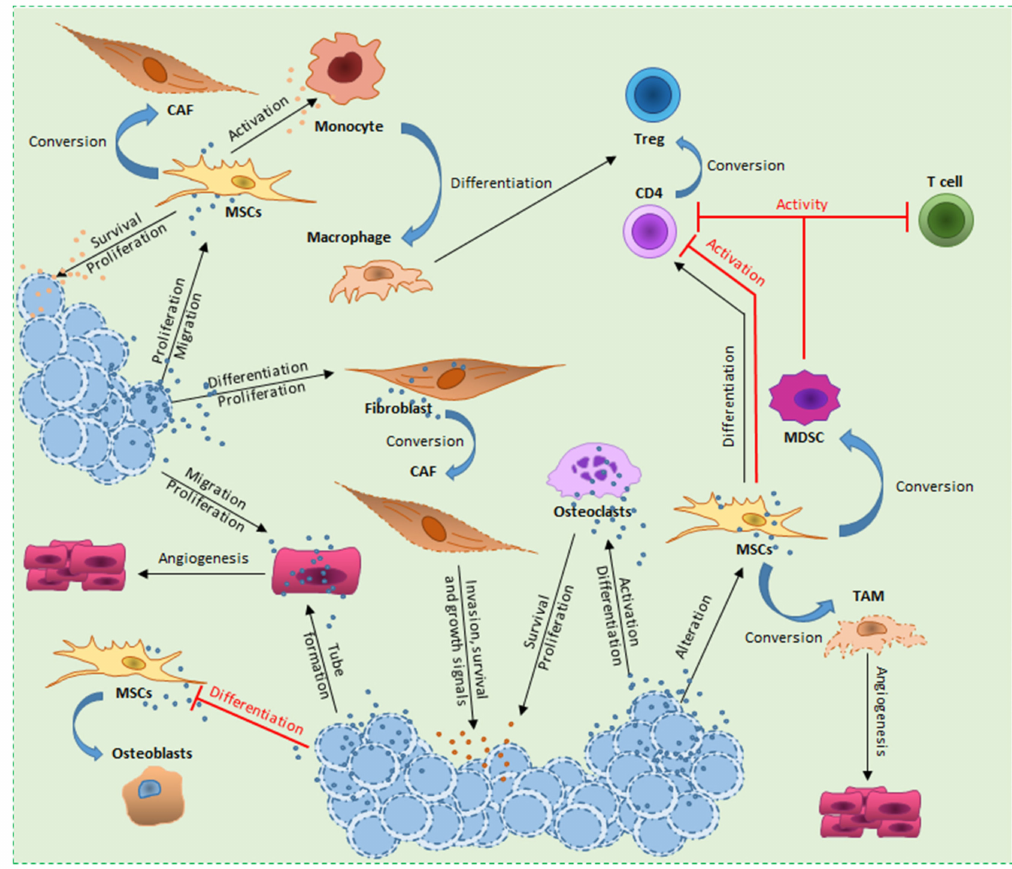
Figure 2. Overview of hematological malignancy-derived small EV effects on stromal cells. In the tumor-stroma communication, TEVs play an essential role in re-shaping the microenvironment. Small EVs coming from di ff erent tumors have been described to induce di ff erentiation and increase proliferation of fibroblasts. Through the transfer of di ff erent molecules, TEVs convert fibroblasts and MSCs into CAFs which in turn boost tumor invasion, survival and growth. TEVs have the ability to block the MSCs physiological di ff erentiation into osteoblasts causing a progressive bone loss. Under the activity of TEVs, MSCs are further altered in proliferation and migration, resulting in the release of MSC-derived small EVs which in turn boost survival and proliferation of the tumor cells. MSC-derived small EVs mediate immunosuppression in various immune-e ff ector cells, with Tregs being one of the most deregulated immune cell subtype. Indeed, MSC-derived small EVs directly target CD4 + T cells, thus reducing their activation and expansion towards Treg compartment. Furthermore, the aberrant activation of monocytes leads to di ff erentiation into macrophages and consequently Tregs expansion. ECs are an essential component of the microenvironment necessarily for angiogenesis. ECs are actively targeted by TEVs with the aim to increase vascularization in the tumor surrounding, leading to higher proliferation and tumor spreading. Finally, osteoclasts, a further component needed for bone remodeling, under the e ff ect of TEVs show a deleterious activation and di ff erentiation which lead to bone loss and pro-tumorigenic chemokine and growth factor